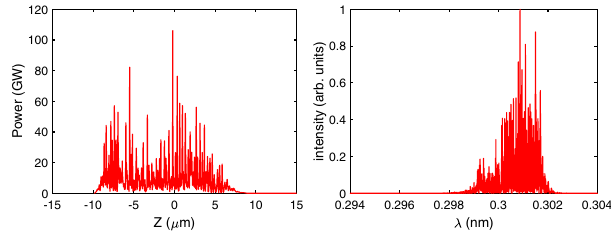
FIG. 7. Simulated FEL power profile (left) and spectrum (right) of the delayed electron beam with an energy of 5.11